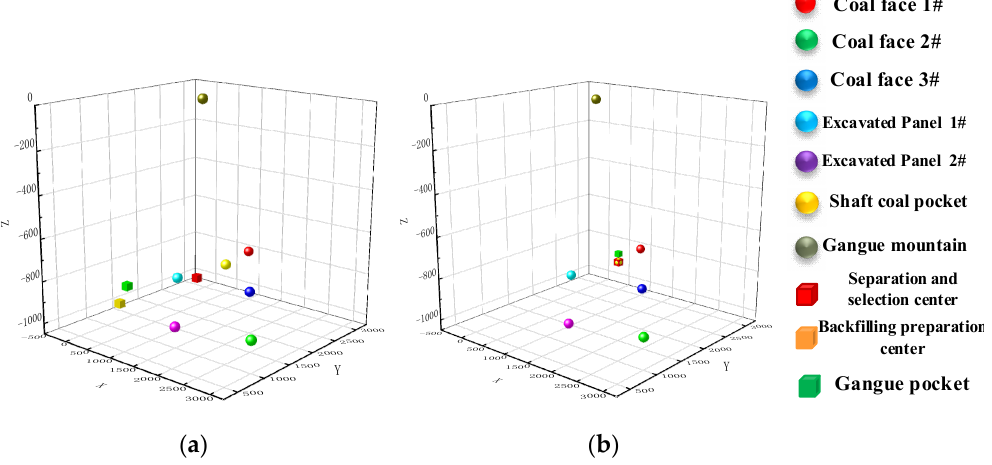
Figure 6. The spatial position relationship diagram of the logistics nodes (group 2): ( a ) PSO algorithm, ( b ) PSO–QNMs algorithm.